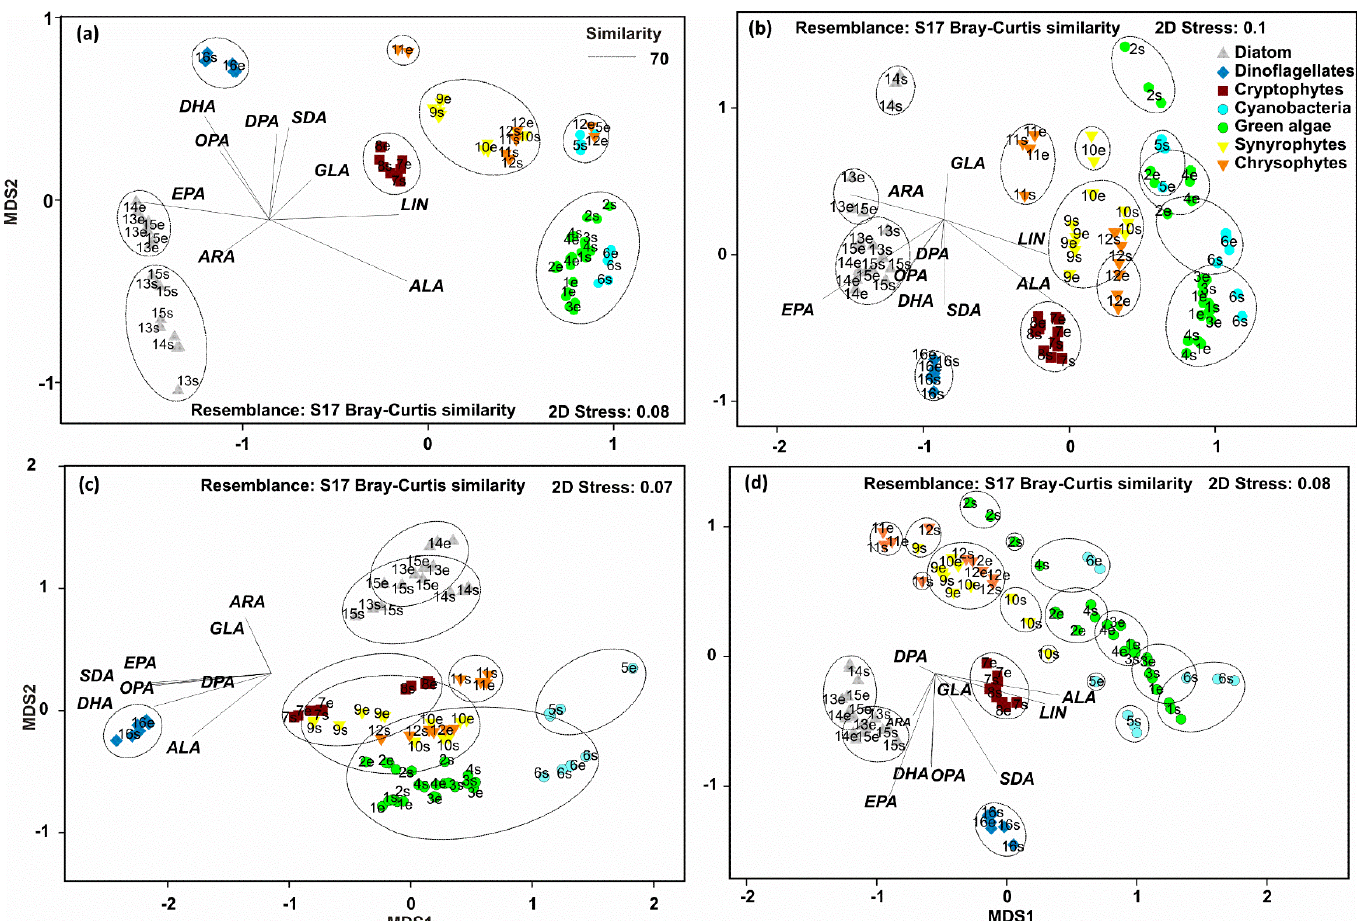
Figure 4. Non-metric multidimensional scaling plots of Bray Curtis similarity of percentages ( a ), biomass content ( b ), cell content ( c ), and daily production ( d ) of ω - 3 (ALA, SDA, EPA, DHA) and ω -6 (LIN, GLA, ARA, DPA) PUFA in cultured 16 phytoplankton strains (see Table1). Golden algae are divided here into Synyrophytes and Chrysophytes to demonstrate the difference in these classes. Abbreviations after strain number: e = exponential phase and s = stationary phase.